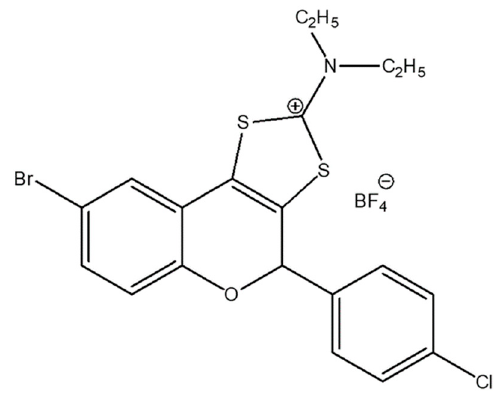
Figure 1. Structure of flavonoid BrCl-flav.